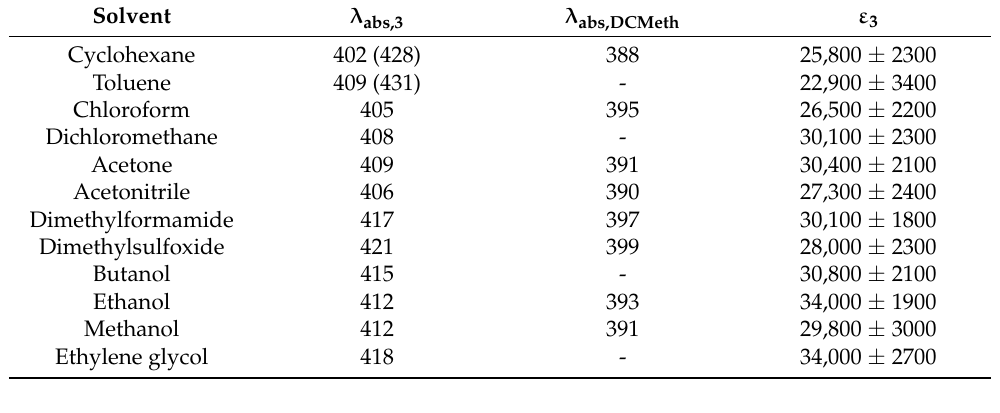
Table 6. Absorption peak wavelength of 3 in the different solvents of Table 1, λ that of DCMeth, λ abs,DCMeth , reproduced, when available, from [39] for the sake of straightforward comparison. The molar extinction coefficient of 3 at the absorption peak, ε 3 , is also reported.